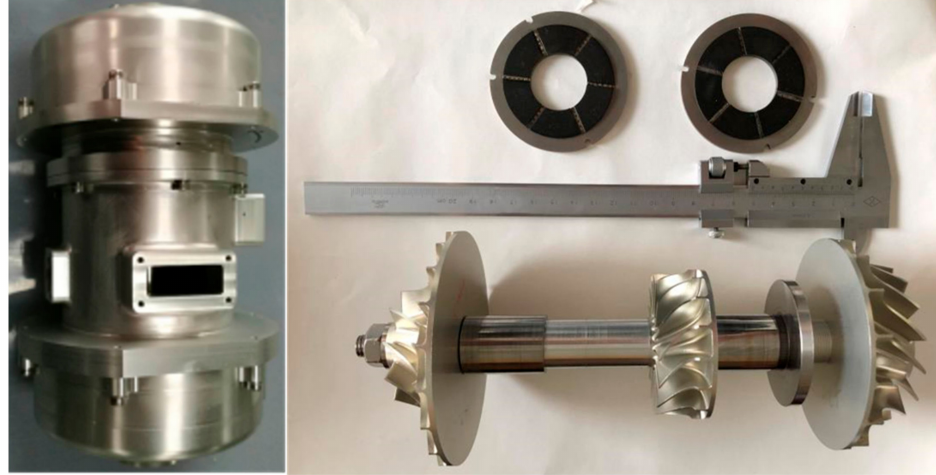
Figure 5. Airborne turbo cooler by Xi’an Jiaotong University